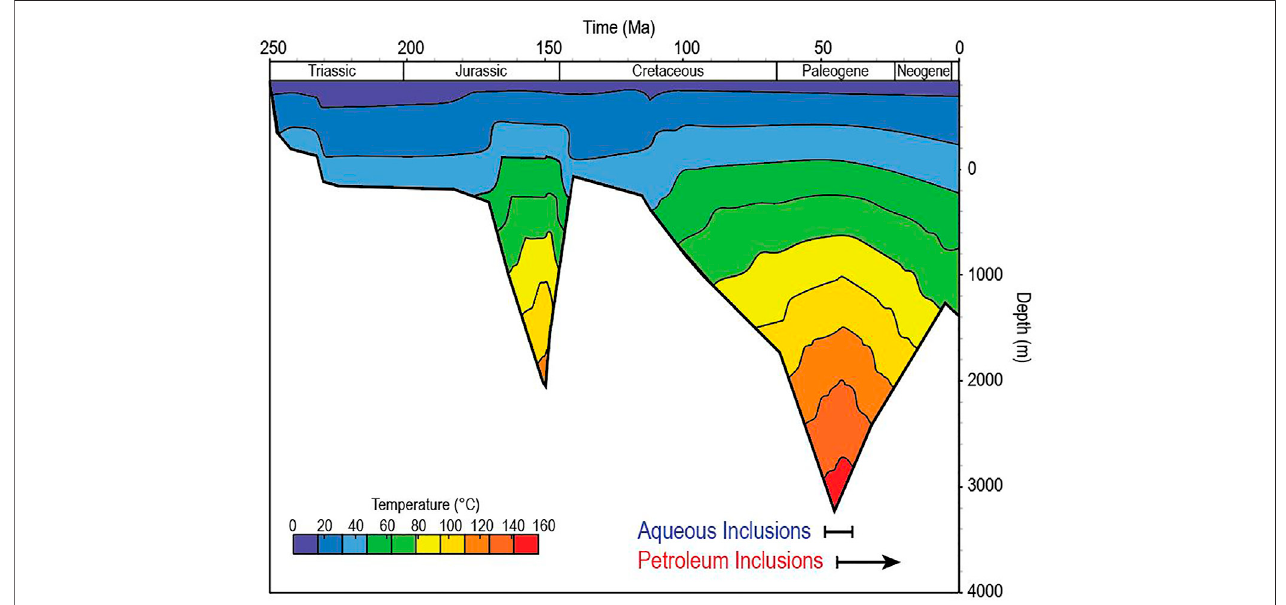
FIGURE11| Burialandthermalhistoryforthiswell.DataderivedfromtheBritishColumbiaOilandGasCommissiondataarchives.Estimatedtimingforentrapment of aqueous and petroleum inclusions shown occurring during the Laramide Orogeny ~50 Ma.